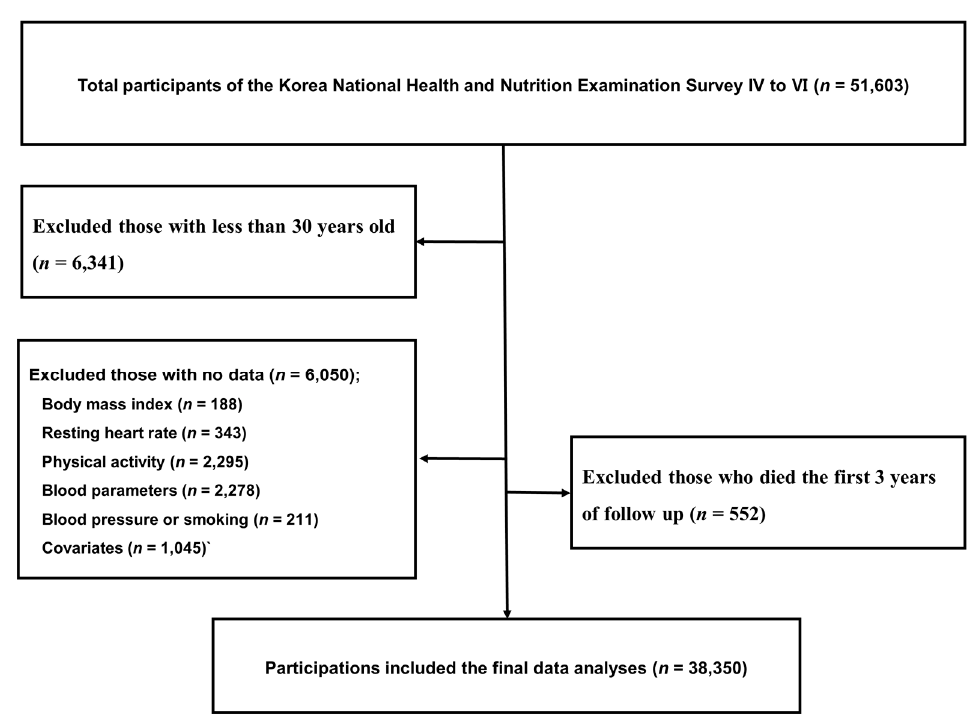
Figure 1. A flow chart of selection of study participants.